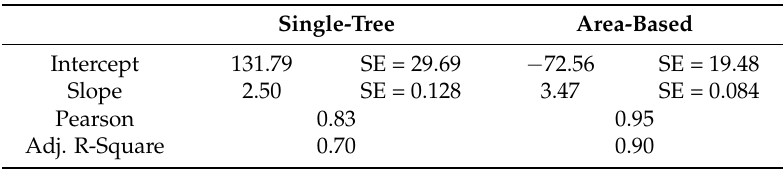
Table 2. The parameters and performances of the GLM used to predict the AGB on the basis of CPA from the single-tree and area-based